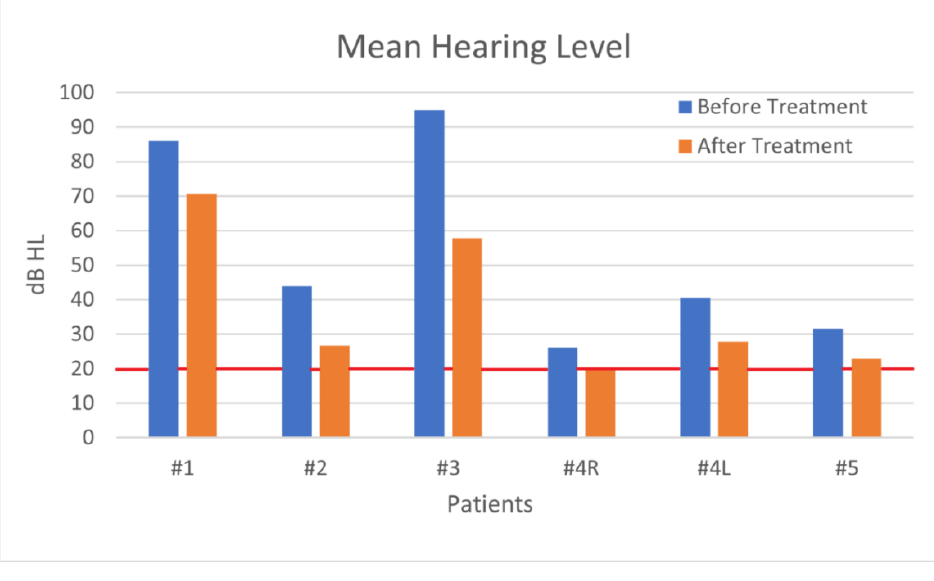
Figure 8. Each patient had an improved mean hearing level after